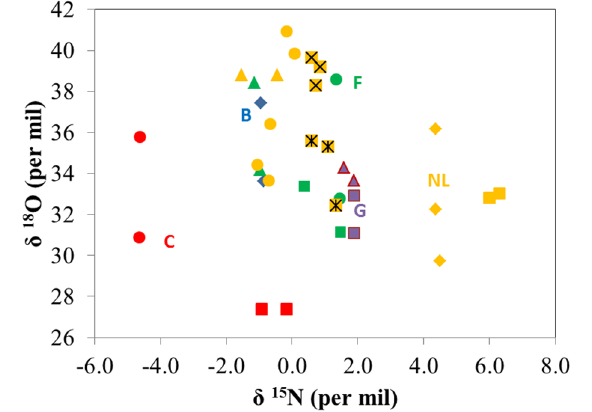
Figure 2. 2D-plot of N and O isotopic data of C. majalis rhizomes originating from five countries (Belgium (B, blue), China (C, red), France (F, green), Germany (G, purple) and The Netherlands (NL, yellow)), i.e. , stable isotope ratios 18 O/ 16 O ( δ 18 O) and 15 N/ 14 N ( δ 15 N). Different colors indicate different countries, symbol shapes indicate different origins within countries; identical symbols indicate replicate provenance samples; least significant difference (LSD) ( p < 0.05) values: 0.7 ( δ 15 N), 4.6 ( δ 18